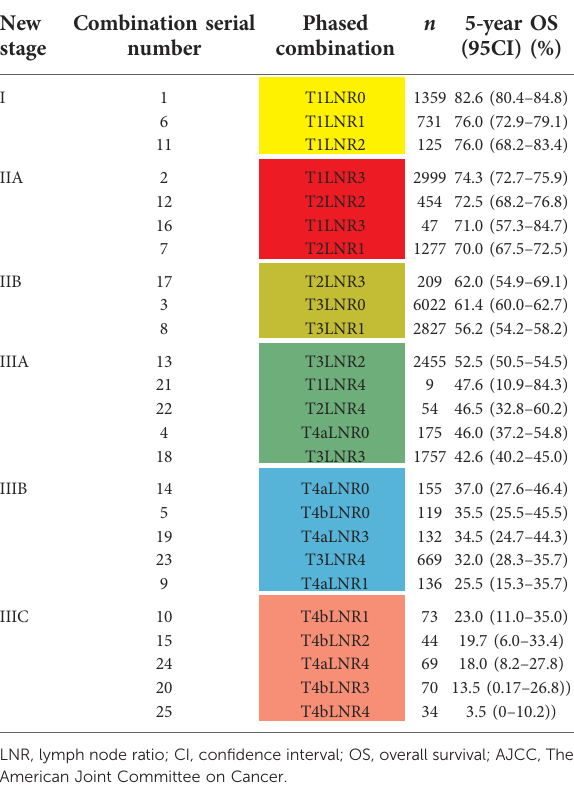
TABLE 4 The new staging system based on the AJCC T stage and LNR grouping.